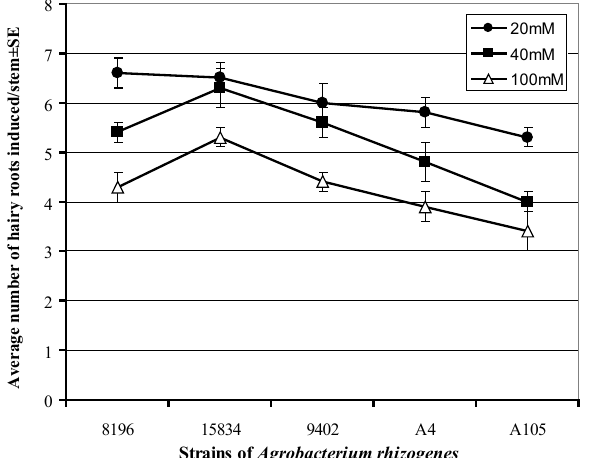
Fig. 9. Effect of acetosyringone on induction of hairy roots in petiole of muskmelon